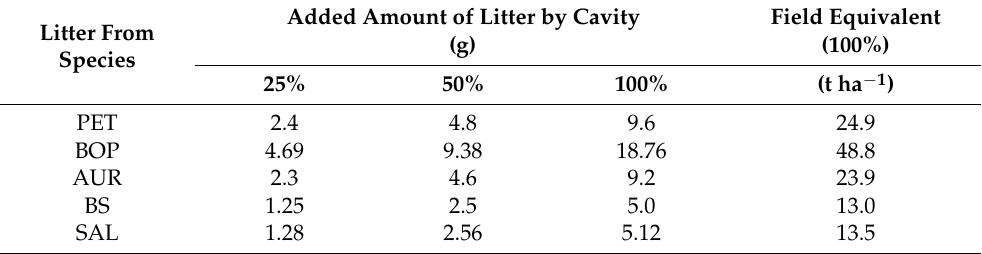
Table 1. Proportions (i.e., grams) of litter equivalent to 100%, 50% and 25% total weight of the collected surface of 16 m 2 , added to each seedling per treatment. PET: T. aspen ; BOP: White birch ; AUR: Alder sp.; BS: B. spruce ; SAL: Willow